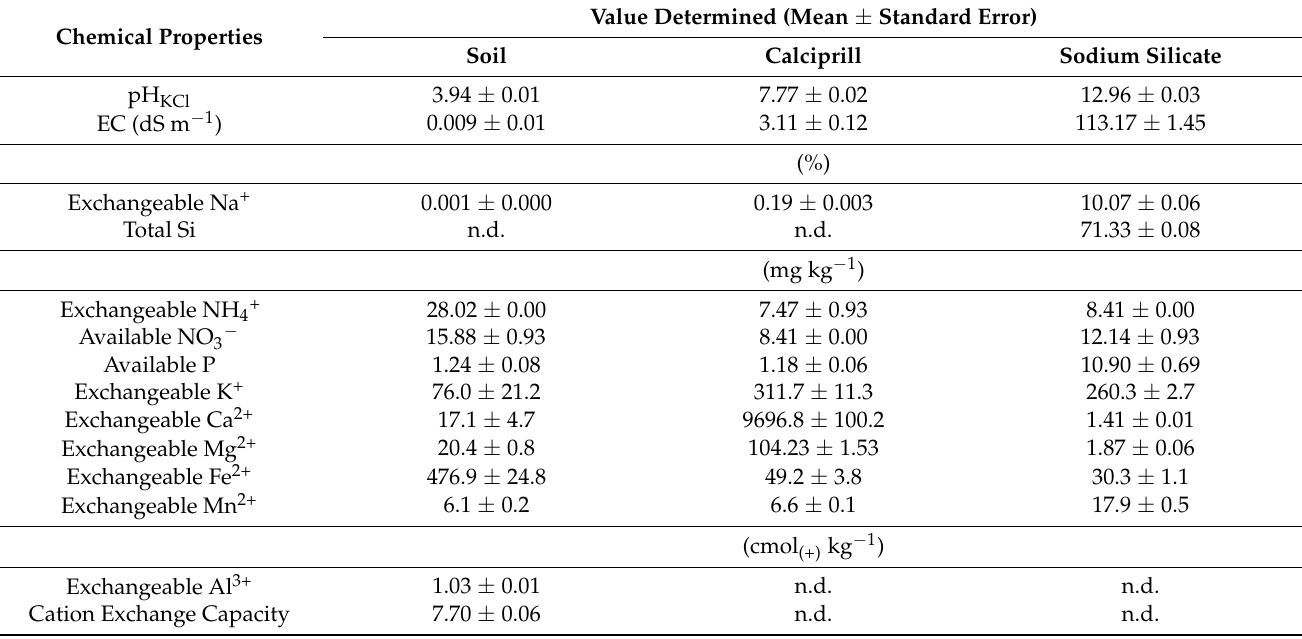
(Table 2). For each experimental unit, a 500 mL beaker was placed under the perforated container for leachates collection at five day intervals over the 30 days of leaching. Table 1. Initial chemical properties of Bekenu series ( Typic Paleudult ), Calciprill, and sodium silicate.